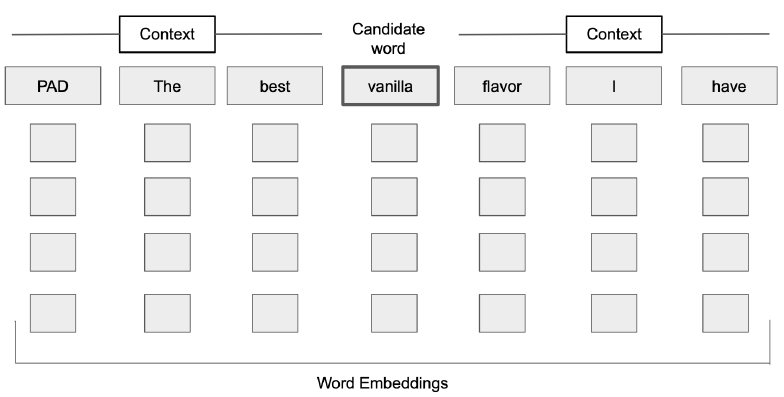
Figure 2. Conceptual example of an input sequence for training the model. The before and after context of a candidate word is extracted from a text review. This is then converted into a numerical representation using GloVe word embeddings for each context word and the candidate word with a PAD being the zero vector.